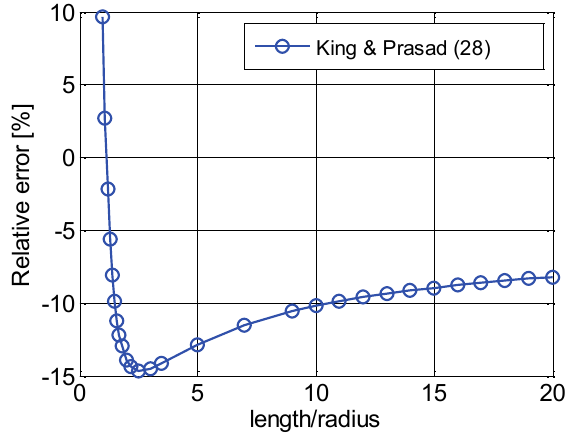
Figure 3: Relative error of formula (28) due to King and Prasad, plotted as a function of the ratio of length to radius.